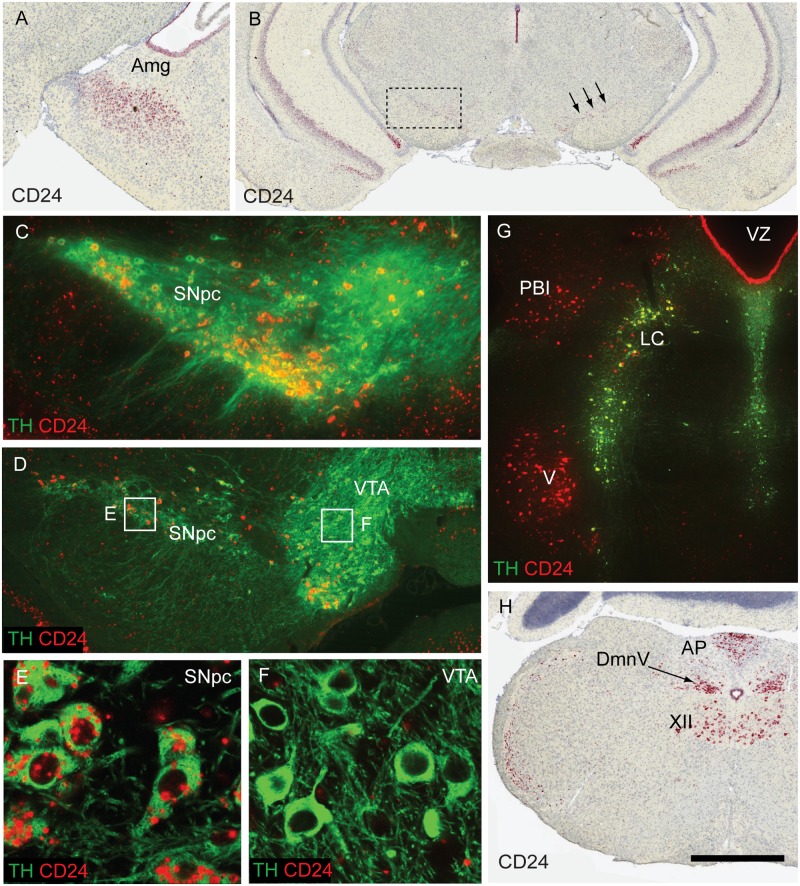
In situ hybridization of Cd24 expression on the adult mouse brain.(A) A coronal image of Cd24 expression (in red) in the central amygdala nucleus (Amg). (B) Cd24 transcripts labelling the Substantia nigra pars compacta (SNpc; arrows) in the midbrain. The dashed line boxed area in B corresponds to the panel in C. (C) Cd24 expression in the SNpc, overlaid with tyrosine hydroxylase (TH) immunofluorescent staining. (D) A more caudal section of the SNpc to panel C, demonstrating the lack of Cd24 expression in the ventral tegmental area (VTA). (E) High magnification image of the dashed line boxed area indicated in panel D illustrating the dopamine neuron-specific expression of Cd24 in the SNpc. (F) A similar image to that of panel E (of the dashed line boxed area indicated in panel D), demonstrating the lack of Cd24 expression in the dopamine neurons of the VTA. (G) In the hindbrain, Cd24 transcripts overlapped with the TH+ neurons of the locus coeruleus (LC) and also labelled the parabrachial nucleus (PBl) and the motor nucleus of trigeminal nerve (v). (H) Further down the brainstem, in the medulla, Cd24 expression was present in the dorsal motor nucleus of the vagal nerve (DmnV), the area postrema (AP), and the hypoglossal nucleus (XII). The scale bar in panel H represents 200μm in panel A&H, 500μm in panel B, 100μm in panels C, D and G, and 50μm in panels E and F.